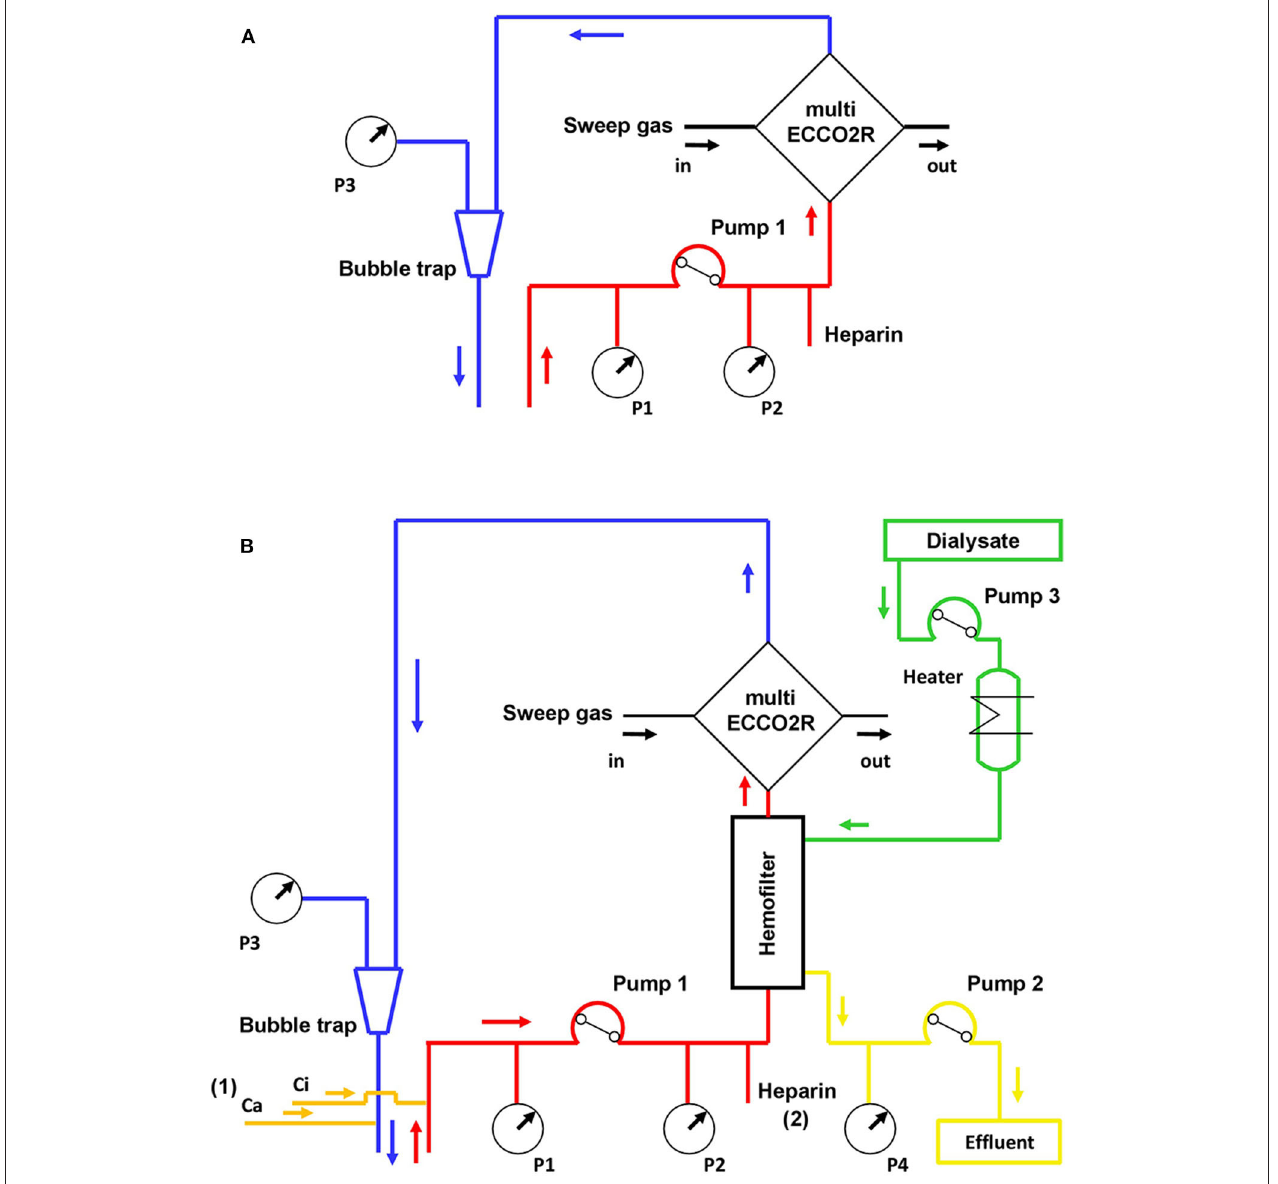
FIGURE 1 | Schematic representation of the ECCO 2 R circuit either as standalone therapy (A) or in-line after the hemofilter for combined ECCO 2 R and RRT (B) . ECCO 2 R in conjunction with RRT may be performed with regional citrate anticoagulation (1) or systemic heparinization (2). Ca, calcium chloride solution; Ci, trisodium citrate solution; Pump 1, blood line; Pump 2, effluent dialysate line; Pump 3, dialysate line; P1, in-flow pressure sensor; P2, pre-filter pressure sensor; P3, out-flow pressure sensor; P4, effluent dialysate pressure sensor; RRT, renal replacement